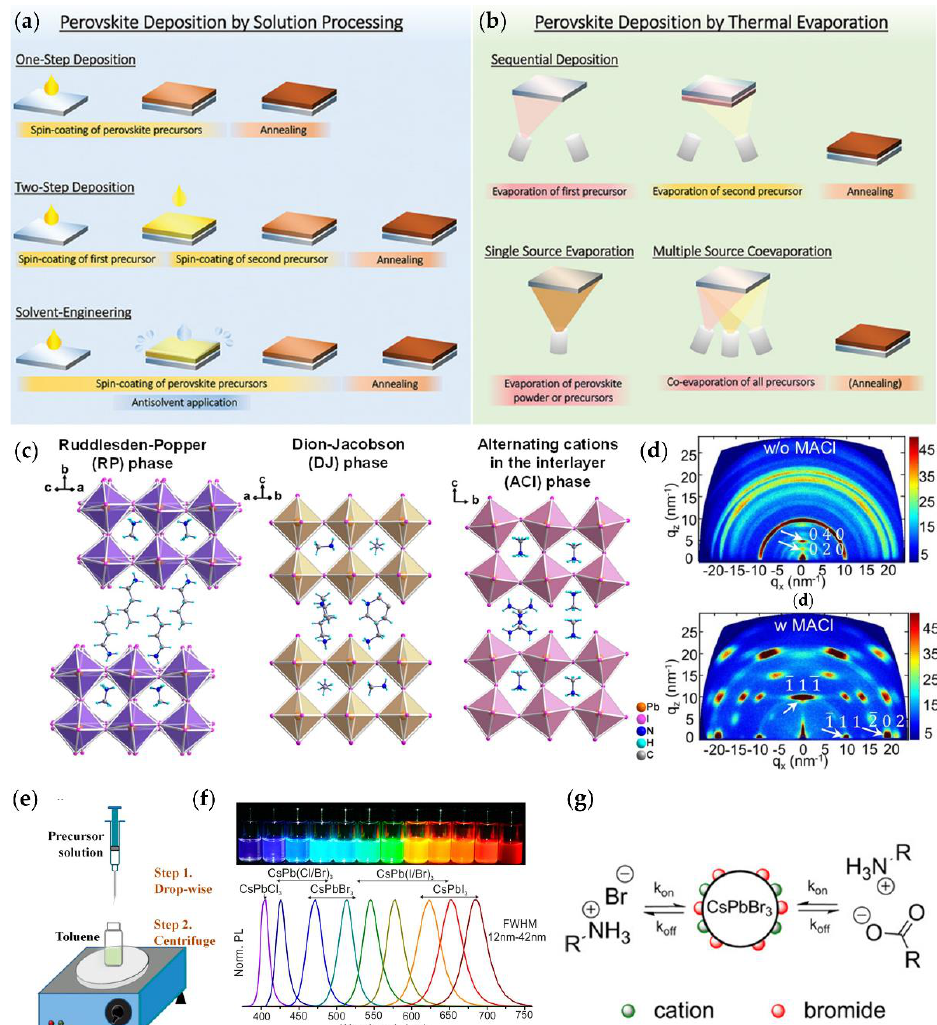
Figure 3. ( a ) Schematic illustration of one-step, two-step sequential, and antisolvent method for 3D LHP film deposition [63]; ( b ) Schematic illustration of single-source, sequential, and multi-source thermal evaporation [63]; ( c ) Examples showing structures of RP, DJ, and ACI phases of <100>-oriented LHP respectively [7]; ( d ) Grazing-incident wide-angle X-ray scattering patterns of (PXD)(MA) 2 Pb 3 I 10 with and without MACl additive [66]; ( e ) Schematic presentation of the LARP method [67]; ( f ) CsPbX 3 PQDs in toluene under UV lamp (365 nm) and the normalized PL spectra [68]; ( g ) Schematic representation of the dynamic ligand binding of OA and OAm to PQD surfaces [69]. ( a , b ) Reprinted with permission from Ref. [63]. Copyright 2020, WILEY. ( c ) Reprinted with